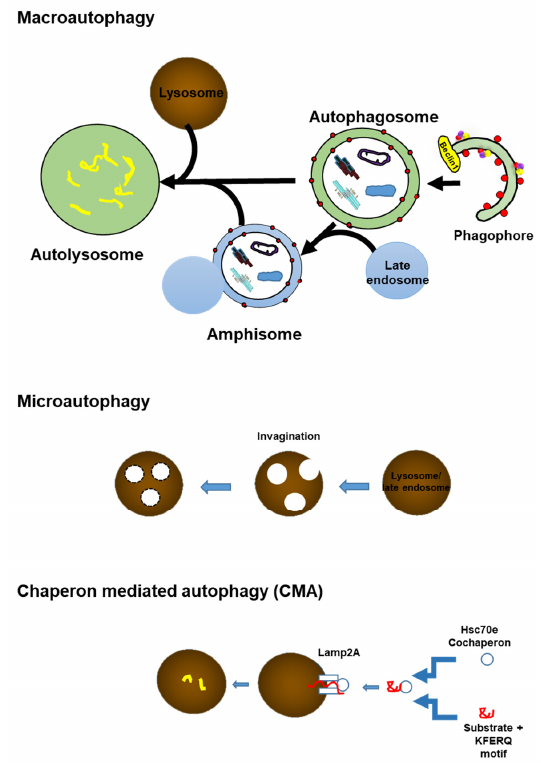
Figure 3. Scheme showing three types of autophagy; Macroautophagy, microautophagy, and the chaperon-mediated autophagy pathway. Macroautophagy: A part of the cytoplasm including the organelle is engulfed by an isolated membrane, the phagophore, which forms an autophagosome. By the fusion of the outer membrane with a lysosome, the internal materials are digested in the autolysosome. Microautophagy: A small amount of cytoplasmic material is trapped in the lyso- some/vacuole through the random process of membrane erosion. Chaperon-mediated autophagy (CMA): Proteins with a KFERQ like motif are identified by cytosolic Hsc 70 and co-chaperons. Then, the substrate proteins are translocated to the lumen of the lysosomes after docking with the lyso-